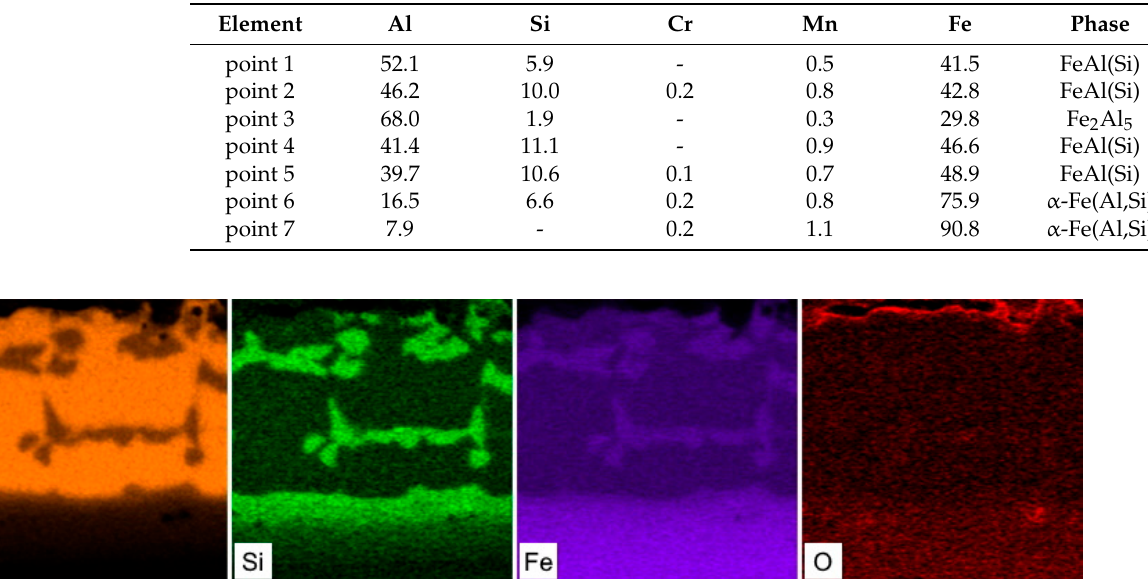
Table 3. The results from the SEM-EDS point analysis, presented as atomic percentages, and the given phase composition.